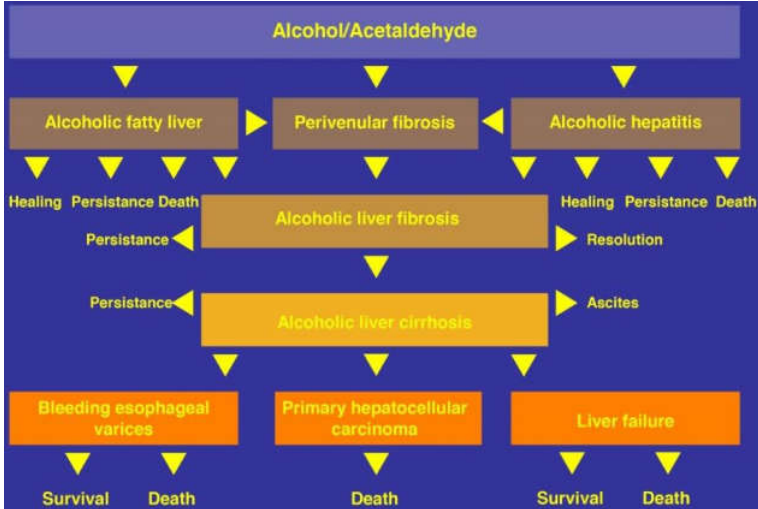
Figure 10. Stages of alcoholic liver diseases with potential clinical outcomes. The clinical outcome is variable among the different stages. Clinical deterioration is most commonly associated with continuation of alcohol